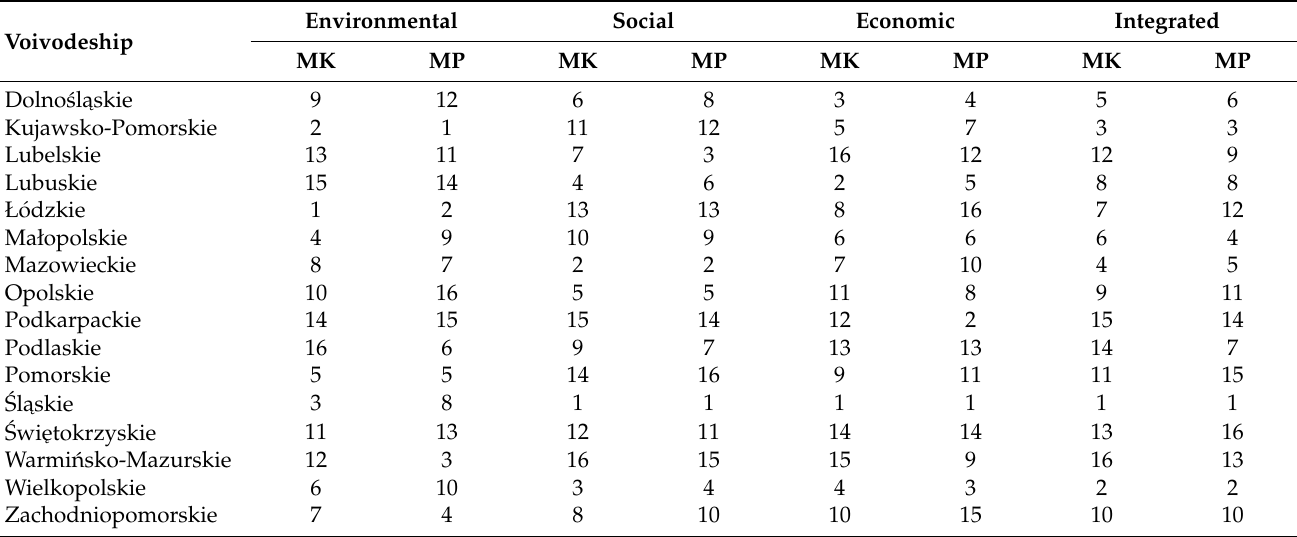
Table 5. Rankings of voivodeships according to particular orders for analyzed voivodeships. Environmental Voivodeship